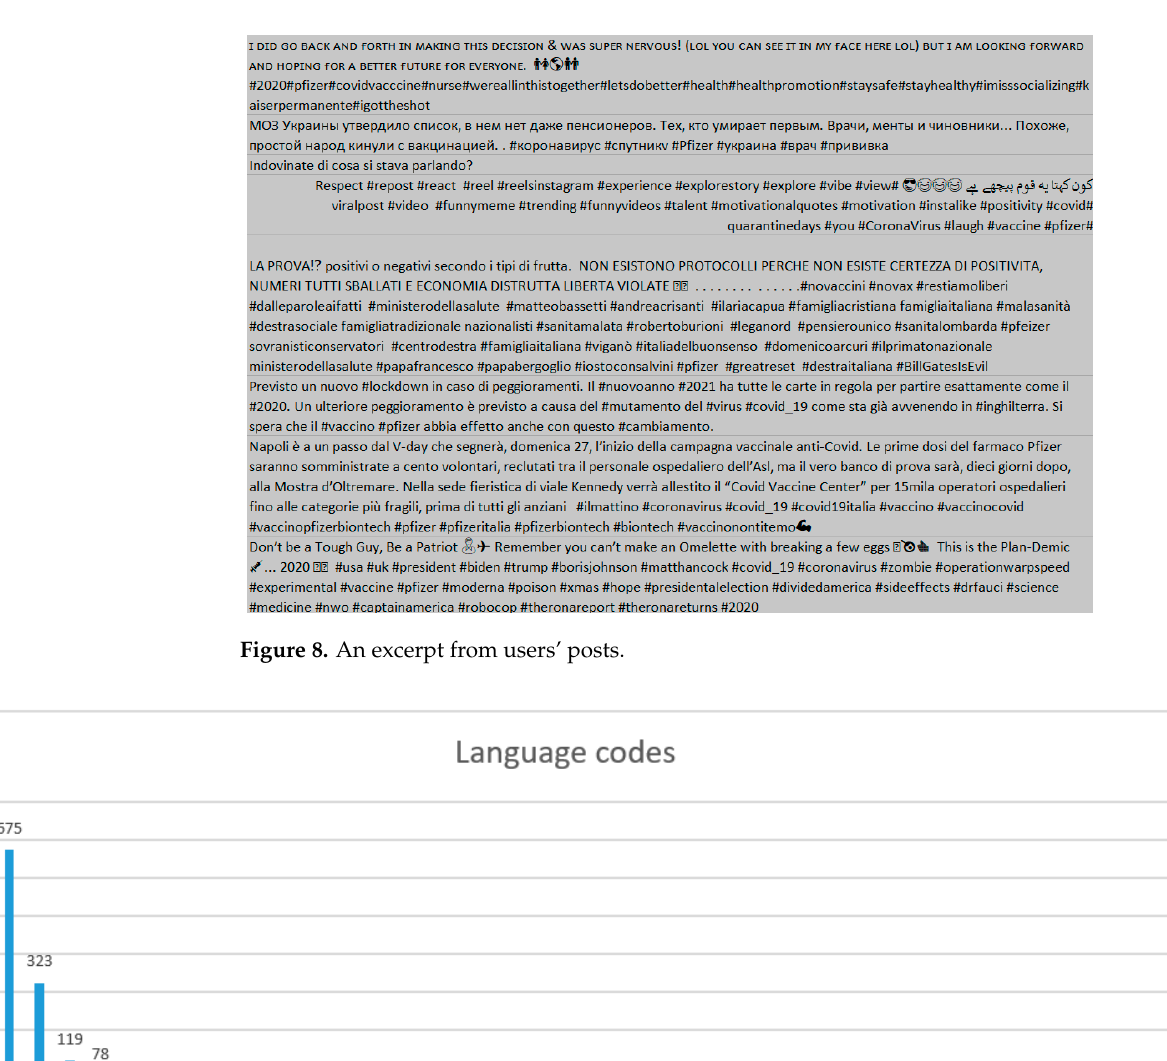
9 of 18 Table 3. Mean and standard deviation (in parentheses) values for the three companies. Characters